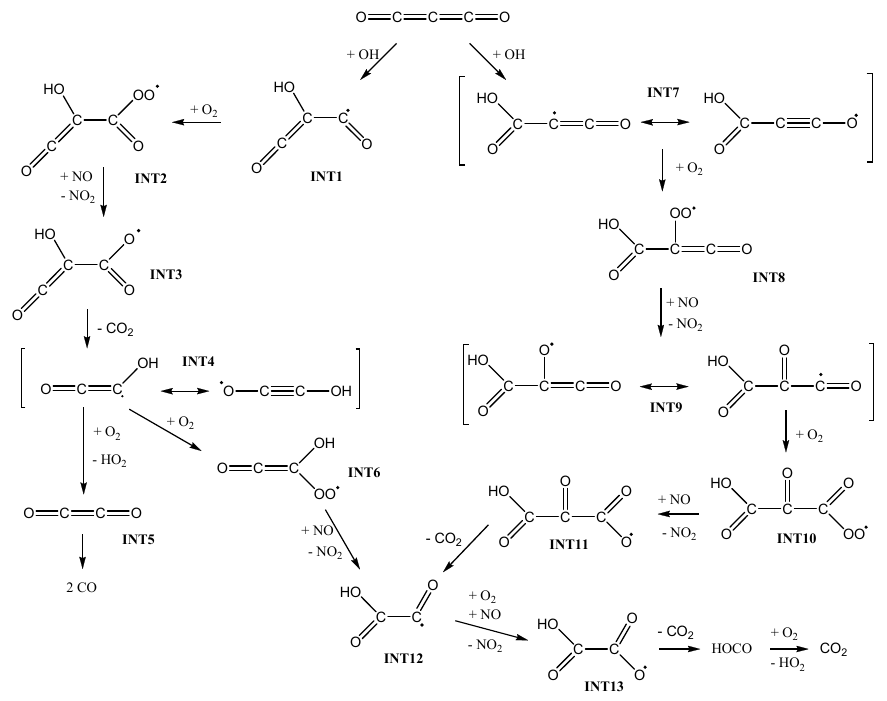
Figure 7. Reaction mechanism of the OH-initiated atmospheric oxidation of carbon